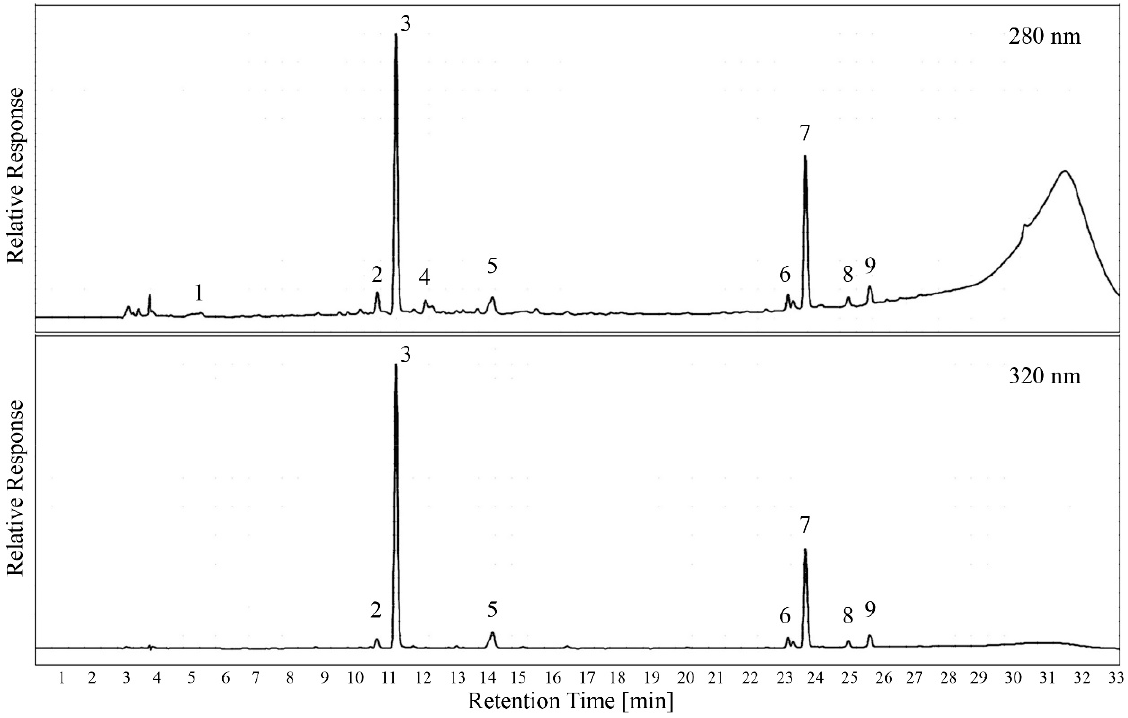
Figure 5. Example chromatogram of the phenolic material in leaf tissue extracts at 280 nm and 320 nm. Peak identi fi cation was performed with pure standards and a spectral comparison with a data- base (1: gallic acid; 2: catechin; 3: caftaric acid; 4: epicatechin; 5: ca ff eic acid; 6: unidenti fi ed hy- droxycinnamic acid; 7: ca ff eic acid derivative; 8: coumaric acid derivative; 9: ferulic acid derivative).